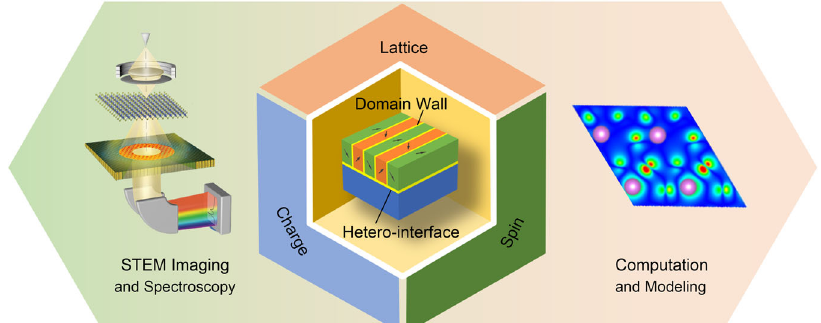
Fig. 1 The key properties and techniques of ferroelectric heterointerface and domain wall that were covered in this article. The heterointerface and DWs in ferroelectric and the electromagnetic properties coupled by the lattice distortion, spin polarization, and charge transfer. These characteristics are often studied by the combination of STEM imaging and spectroscopy, computational, and modeling techniques. Reproduced with permission from refs. 200 and 201 . Copyright [2018] {American Physical Society} and [2018] {American Association for the Advancement of